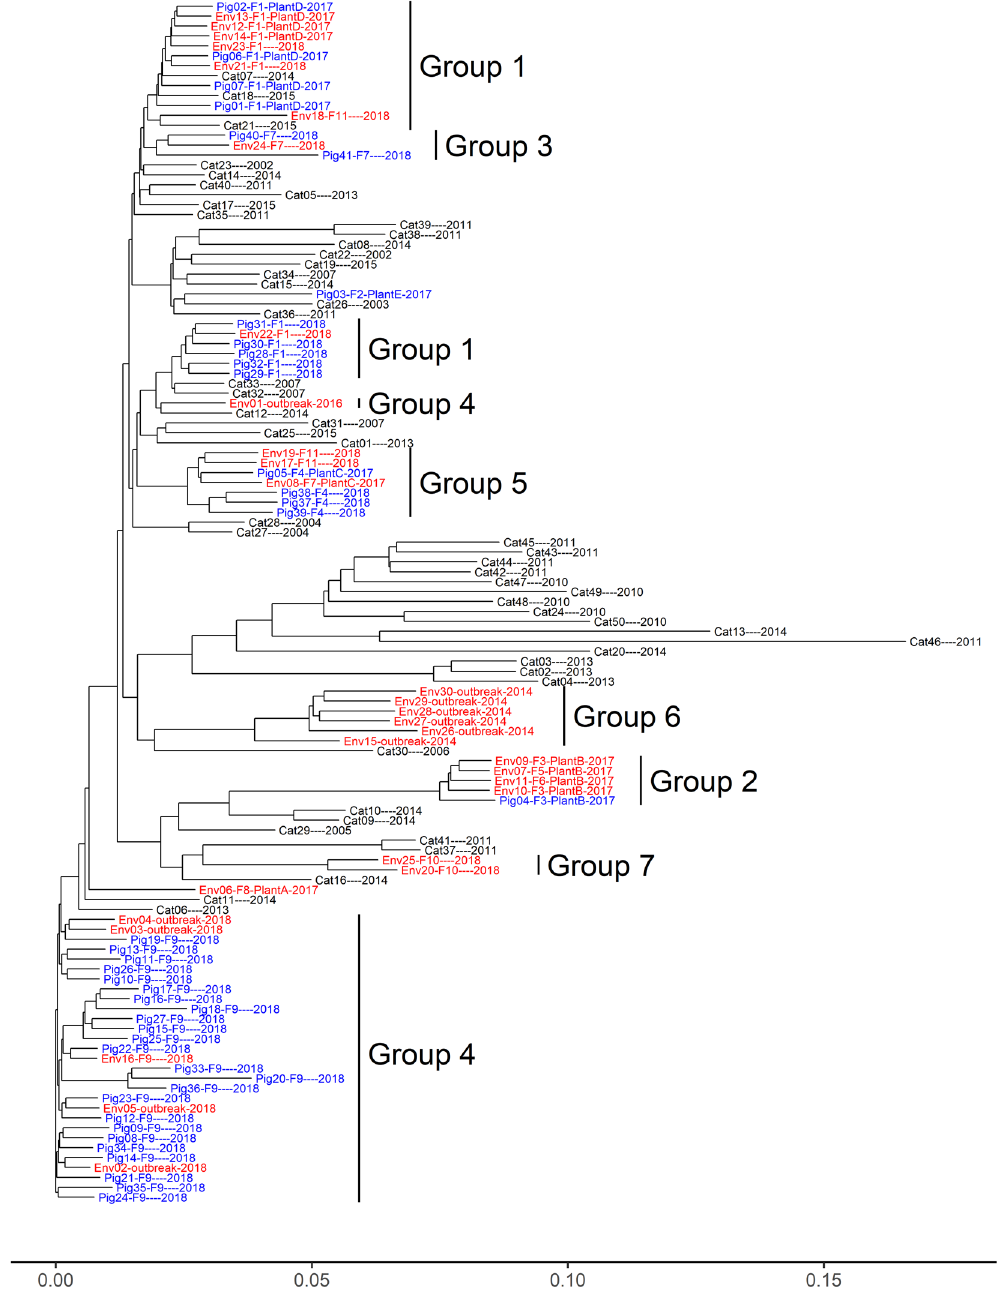
Fig. 4 A neighbor joining tree based on the gene content of 121 E. coli O157:H7 isolates from pigs, cattle and pork production environment. The scale bar represents the Jaccard distance based on the presence or absence of genes between genomes. Each tip in the tree was labeled with the isolate ’ s identi fi cation and, if applicable, its associated farm (F), and/or processing plant (Plant) followed by the year of collection. The isolates recovered from pig (blue) and cattle (black) fecal samples and pig production environment samples (red) were distinguished using different colors. The branches of the seven groups formed by pig and environment isolates in core SNP tree (Fig. 3) are labeled in text in the fi gure. The groups 2, 3, 5, 6, and 7 were also clustered together in this tree, however, groups 1 and 4 were separated into two respectively